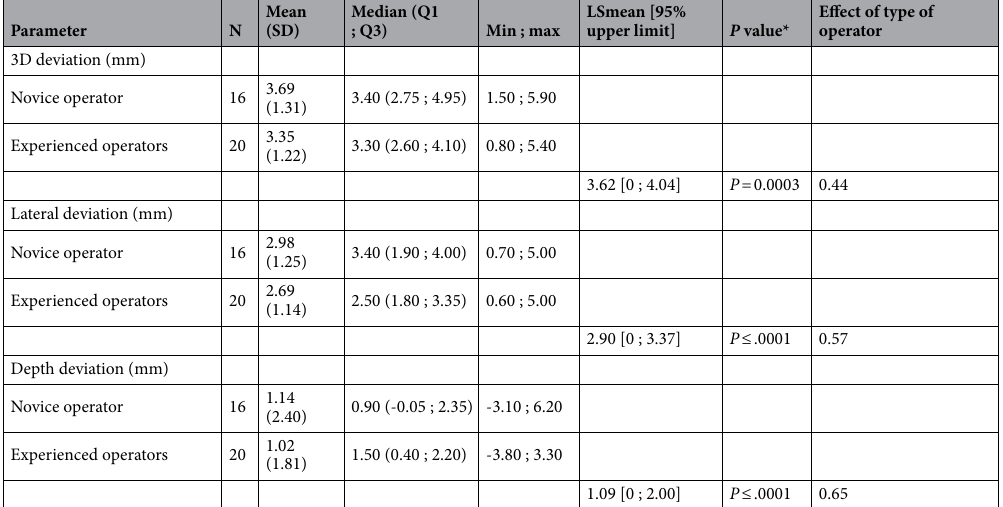
Table 3. Needle placement accuracy (in mm)—Summary table of 3D, lateral and depth deviations— By operator. Analyses based on last needle insertion measure. * P value for unilateral testing distance